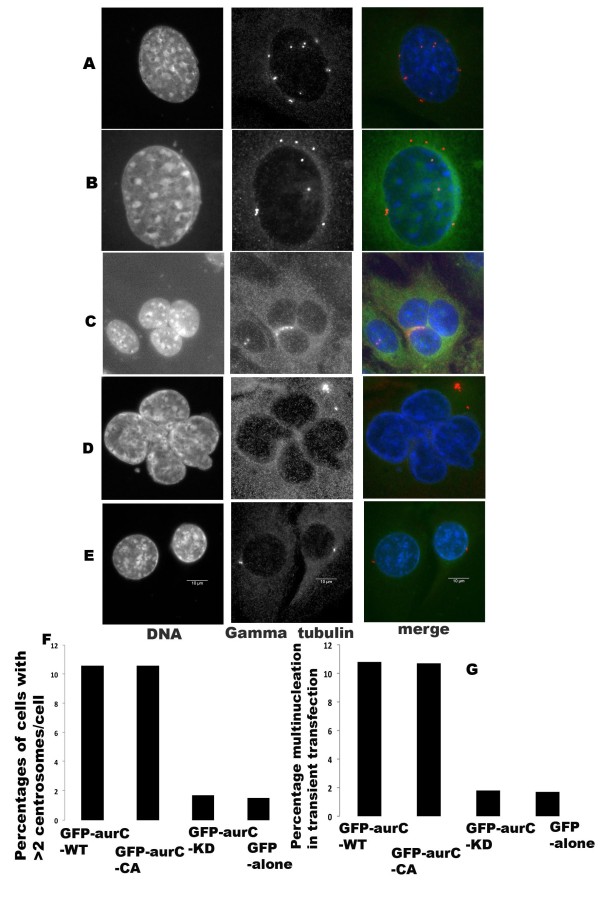
Abnormal centrosome amplification and multinucleation. The immunoflorescent microscopy images (A-G) show abnormal centrosome amplification and multinucleation observed in GFP-aurC-WT, GFP-aurC-CA with negative control GFP-alone. (A&B) more than two centrosomes/cell appeared as white dots with anti-γ tubulin staining in GFP-aurC-CA and GFP-aurC-WT respectively. (C) and (D) show multinucleation (more than one nucleus/cell in GFP-aurC-CA and GFP-aurC-WT respectively. (E) Two centrosomes per cell and only one nucleus/cell in G2 phase of GFP-aur-KD. (F) histogram showing the percentage of cells with more than 2 centrosomes/cell of 96 hours after transient transfection in GFP-aurC-CA, GFP-aurC-WT and GFP-alone cells. (G) histogram shows the percentages of multinucleated cells of 96 hours after transient transfection in GFP-aurC-CA, GFP-aurC-WT and GFP-alone.